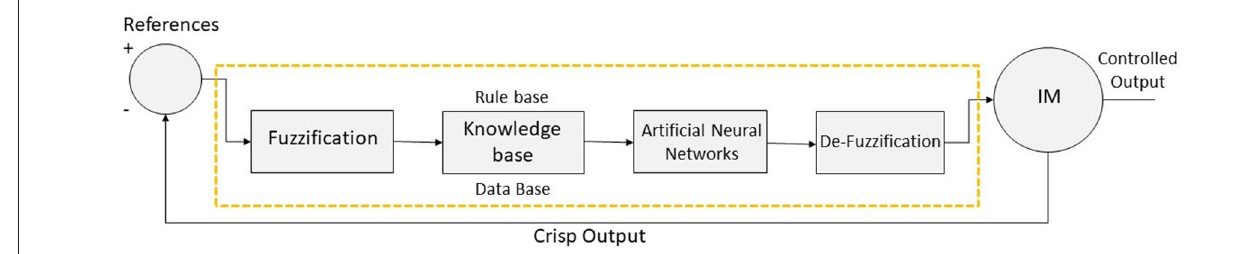
FIGURE 2 | The controller architecture of the ANFIS technique (ANFIS-C).